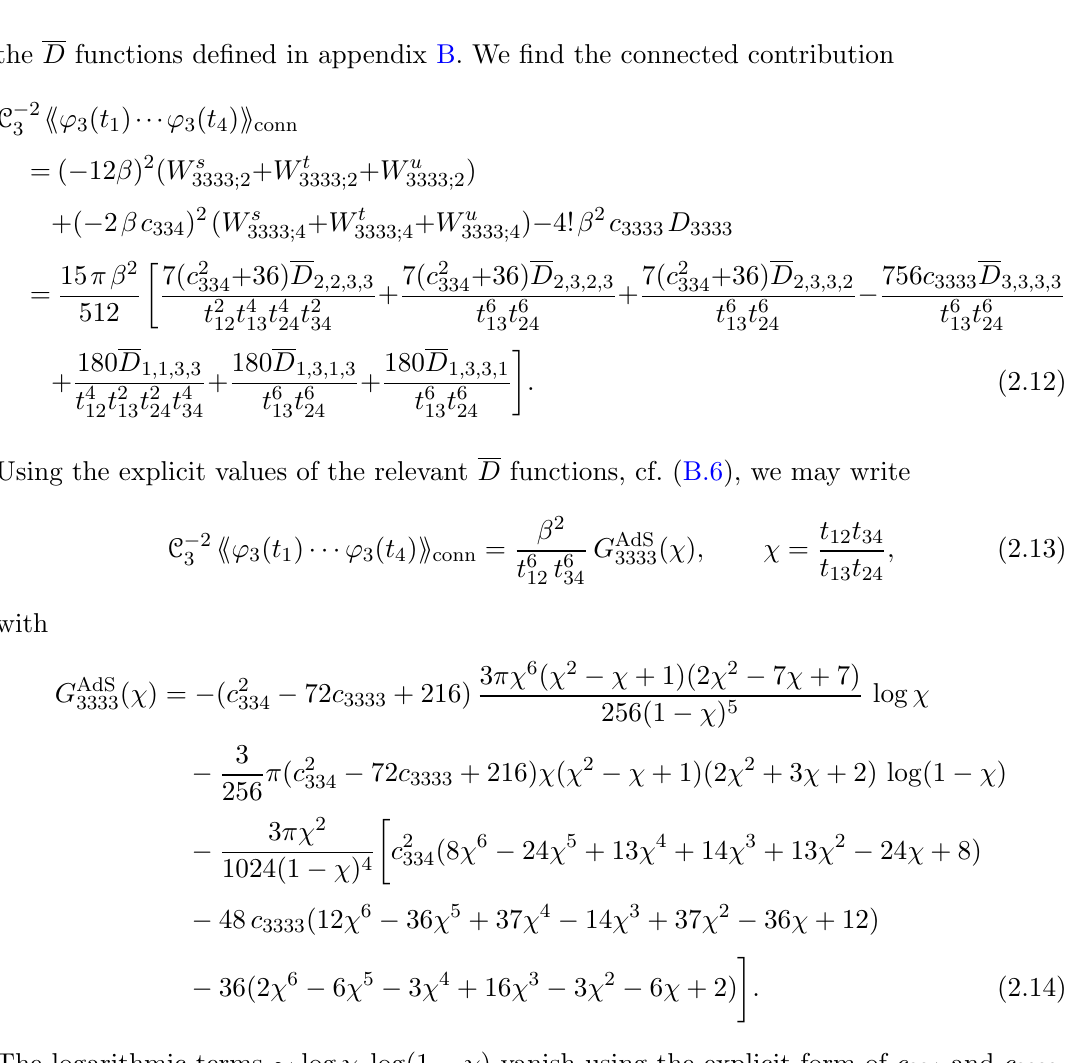
Figure 1 . Tree diagrams contributing ⟪ ϕ 3 ϕ 3 ϕ 3 ϕ 3 ⟫